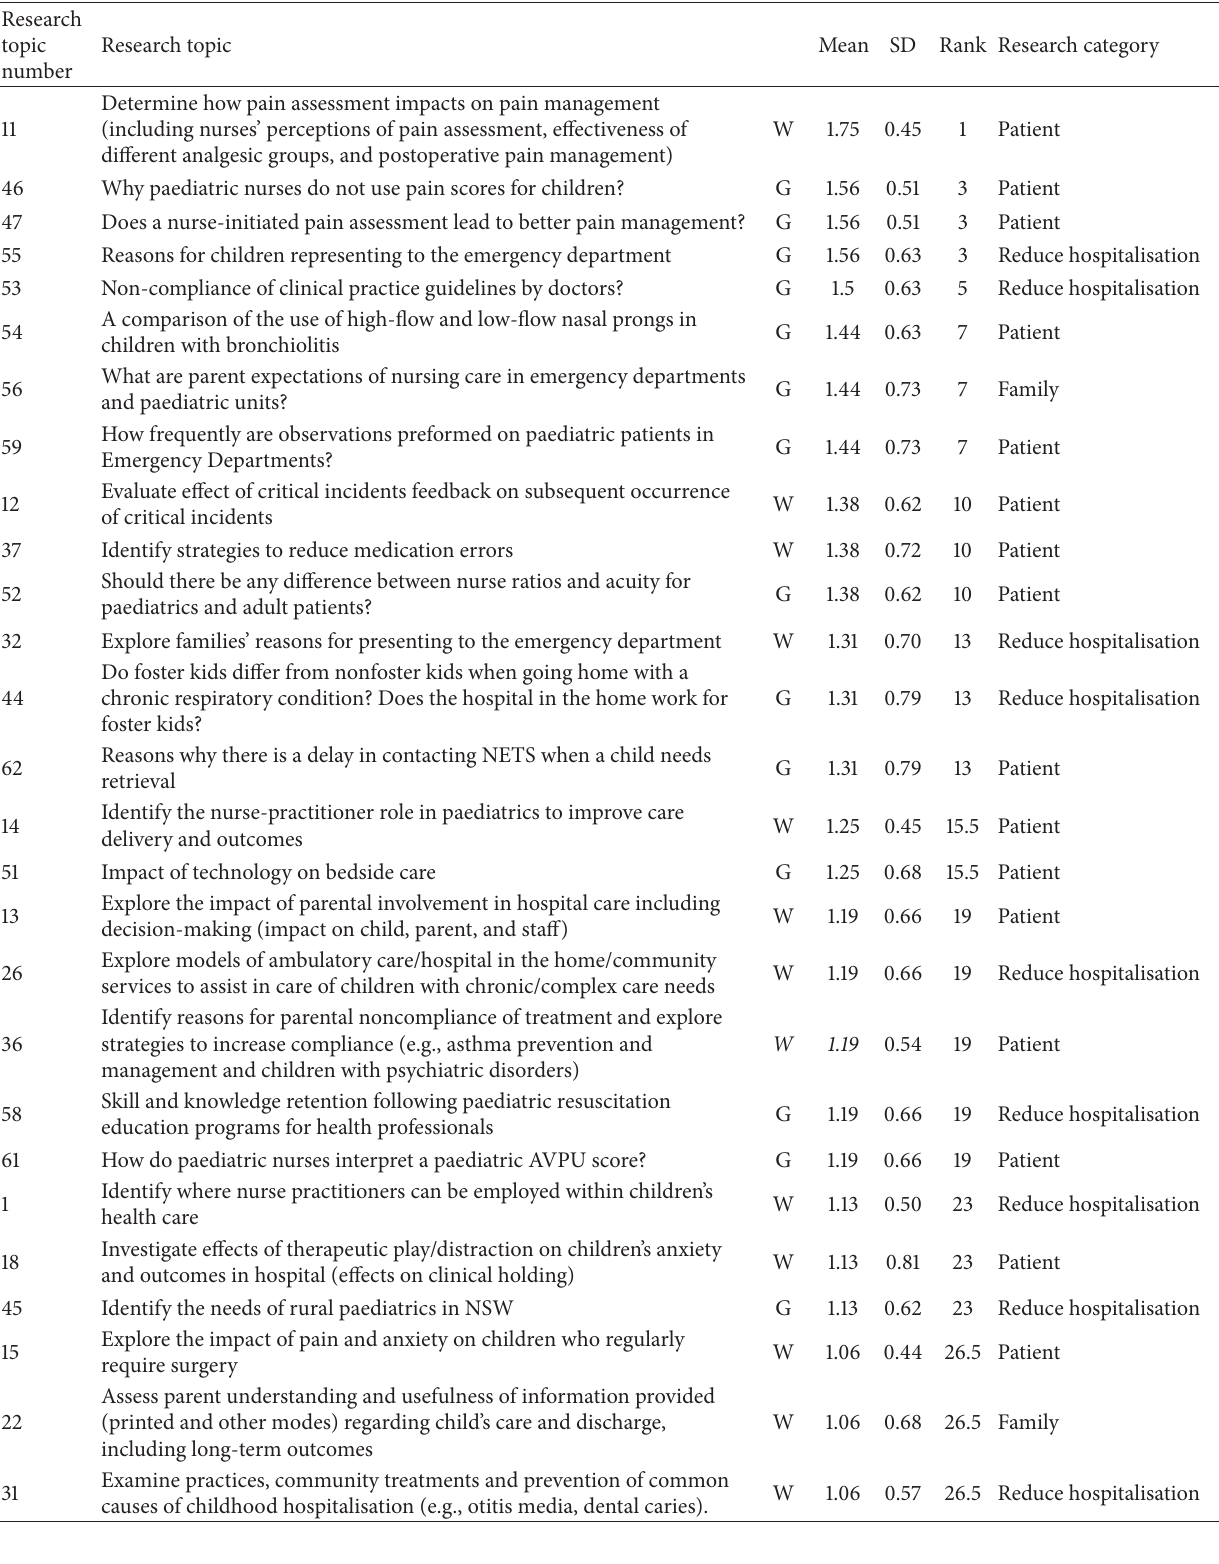
Table 2: Top research priorities nominated by the participants from the combined master list from literature and those they nominated (italicised items from literature [15,